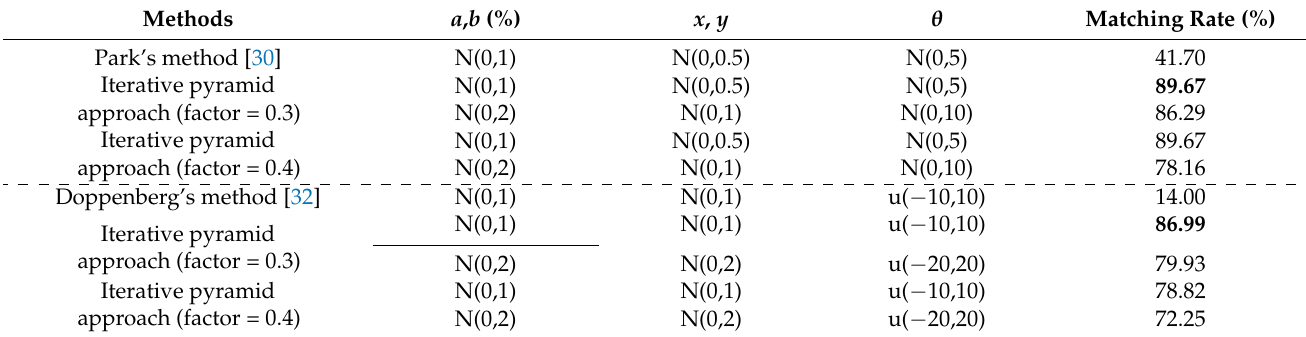
Table 1. Comparison of matching rates calculated by different